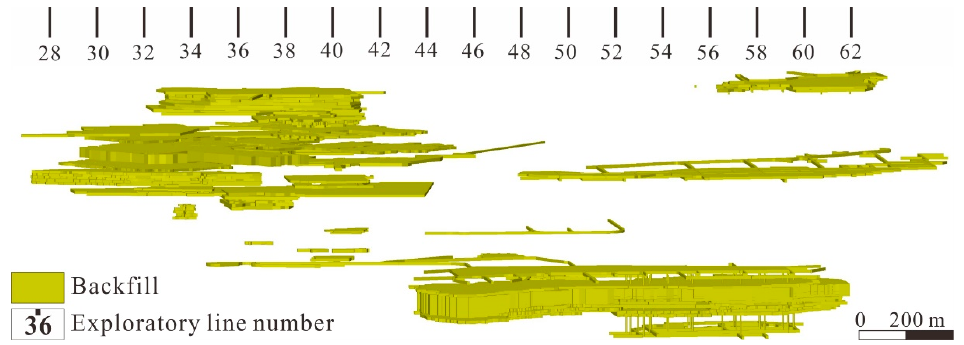
Figure 2. Huge volume filling body in the study area [40].